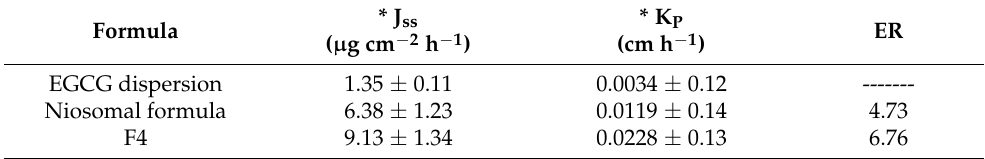
Table 5. Ex vivo permeation parameters of F4, the conventional niosomes, and EGCG dispersion.